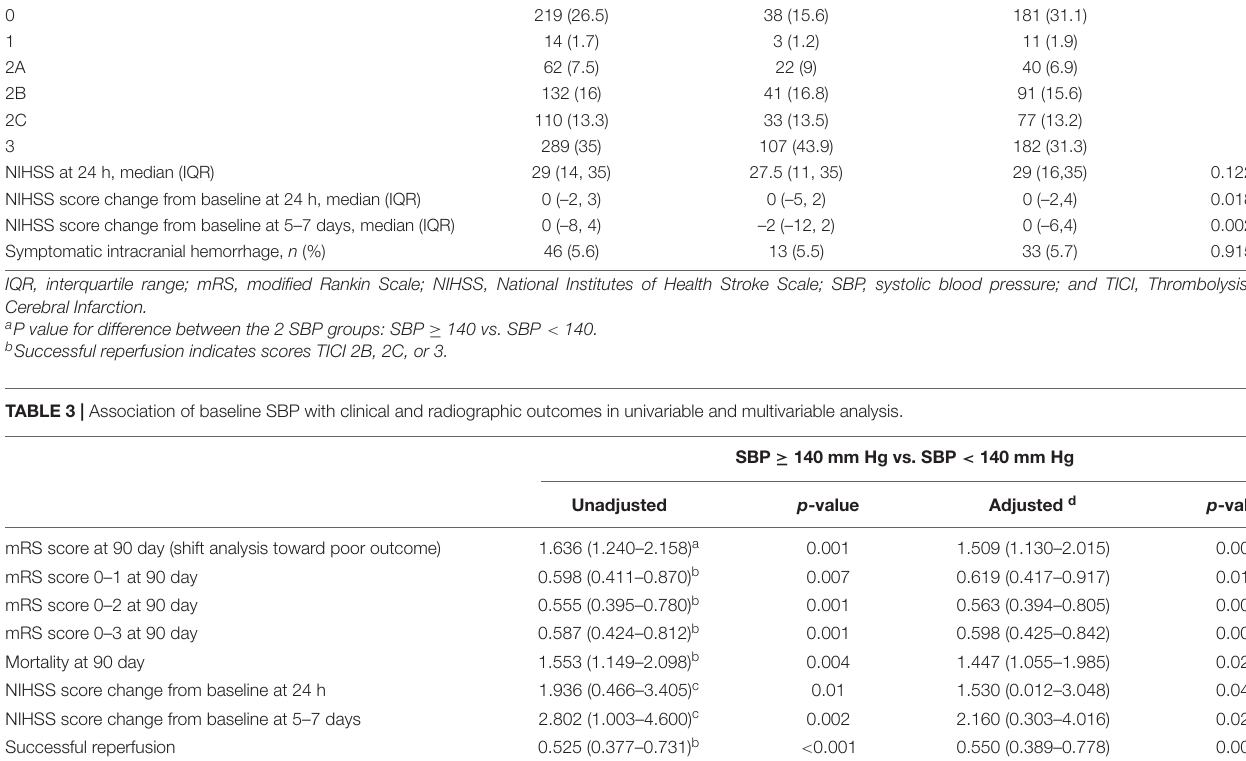
All patients, n = 826